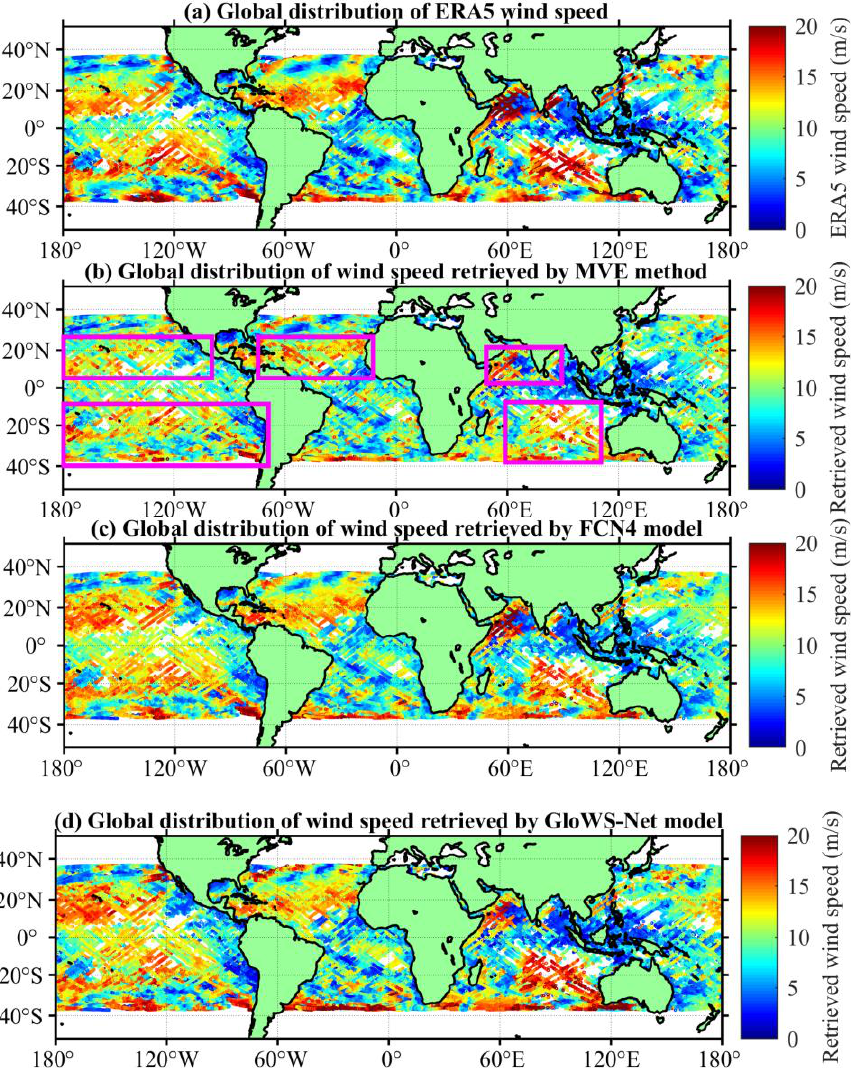
Figure 7. Global distribution of ERA5 wind speed data and retrieved wind speed by different mod- Figure7. els.